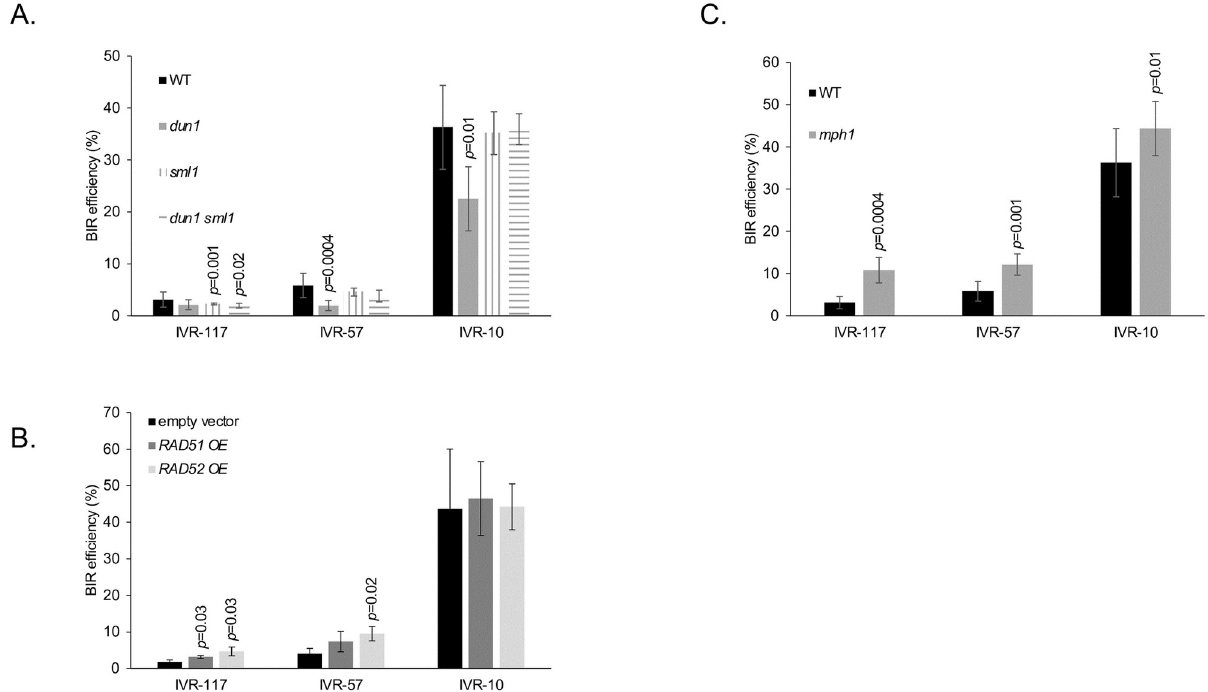
Fig 5. Ectopic BIR efficiency is affected by the trans-acting factors Dun1, Rad51, Rad52 and Mph1. Indicated are Student’s t -test p -values < 0.05 when comparing BIR efficiency from a given locus in a mutant strain with the BIR efficiency from the same locus in the WT strain. Error bars represent standard deviations. A . BIR efficiency of the null mutants dun1 , sml1 and dun1 sml1 from the IVR-117, IVR-57 and IVR-10 loci. WT values are identical to those in Fig 3. Mutant values are the means of four independent experiments for dun1 and three independent experiments for sml1 and dun1 sml1 . B . Similar to A with RAD51 and RAD52 overexpression (OE) from a multicopy vector. Values are the means of three independent experiments for each condition. C . Similar to A with the mph1 null mutant. WT values are identical to those in Fig 3. Values for the mph1 strain are the means of seven independent experiments for IVR-117 and IVR-10 and six independent experiments for IVR-57.